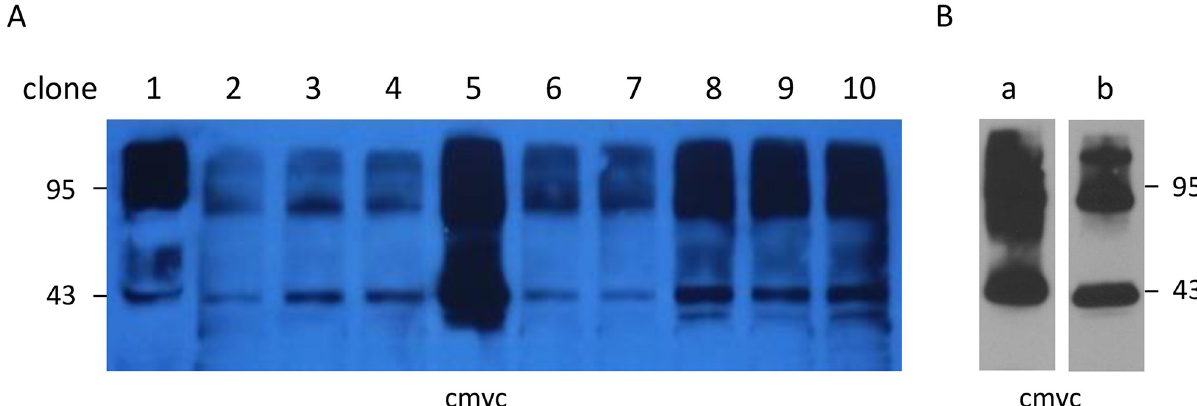
Fig 1. Selection of Pichia pastoris clones expressing hS1P 1 and receptor purification. A Expression of hS1P 1 in different transfected Pichia pastoris clones (1 to 10). B ( a ) Purified hS1P 1 eluted with 300 mM imidazole. ( b ) Expression of hS1P 1 in crude supernatant from Pichia pastoris after cell breakage and centrifugation at 1,000g. Detection of receptors were realized after SDS-PAGE and Western blotting using an anti-cmyc antibody (1:1,000, v/v).